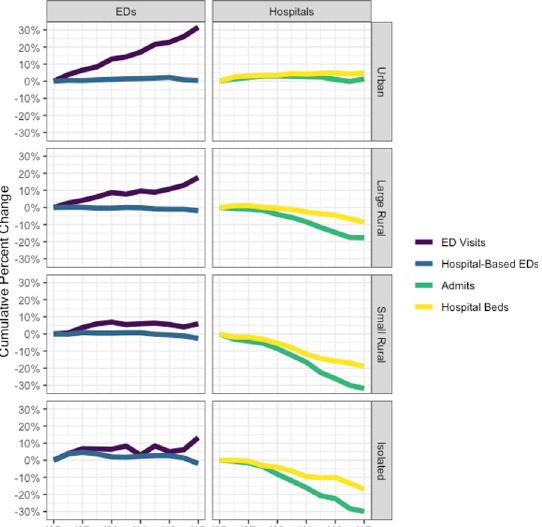
Fig 3. Nationwide percent change from 2005 baseline in ED visits and inpatient hospitalizations by urban-rural category. Source/Notes: Results are nationwide inventory of emergency department (ED) and inpatient availability and utilization from American Hospital Association Annual Survey data. Measures include total yearly ED visits, hospital-based EDs, total yearly hospital admissions, hospital beds.